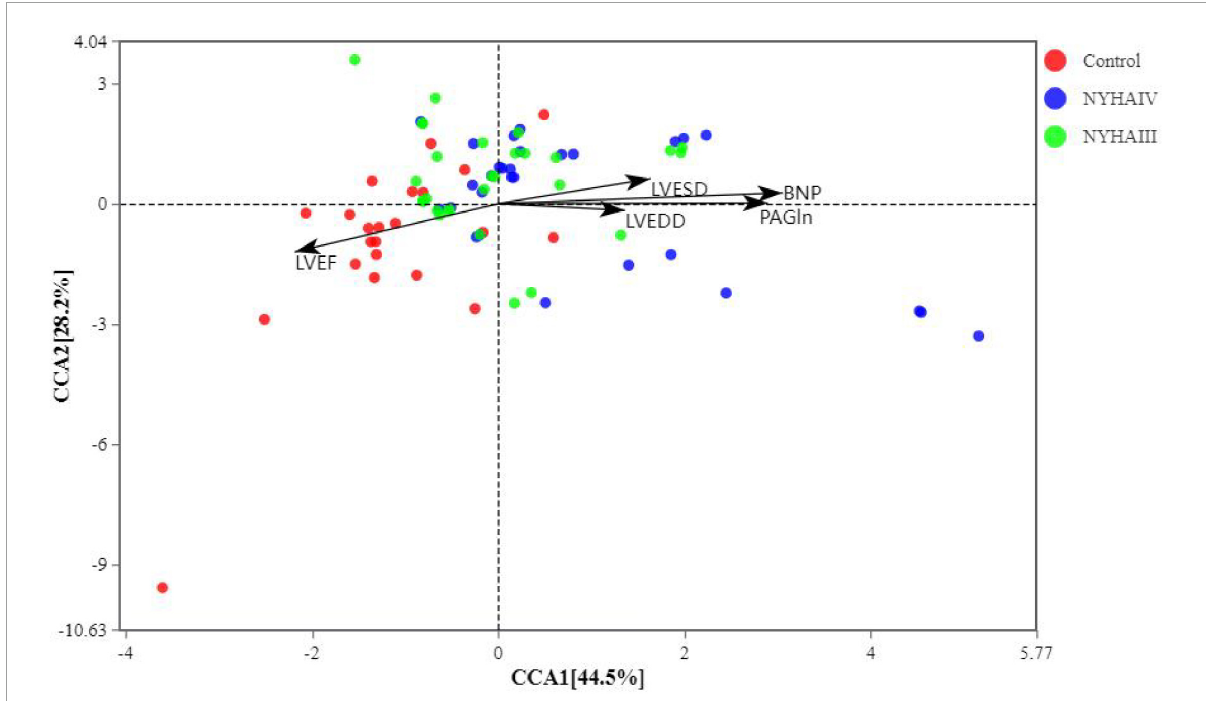
FIGURE6 Canonical correlation analysis (CCA) of the samples (dots) and clinical data (arrows). The black arrows indicate the clinical phenotype data and their lengths indicate the degree of influence of the indicator on the gut